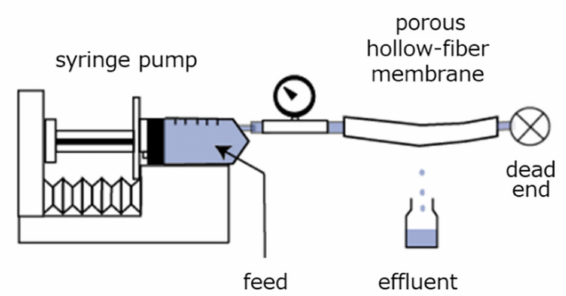
Figure 6. Experimental apparatus for the determination of breakthrough curves of modified porous hollow-fiber membrane for protein adsorption.